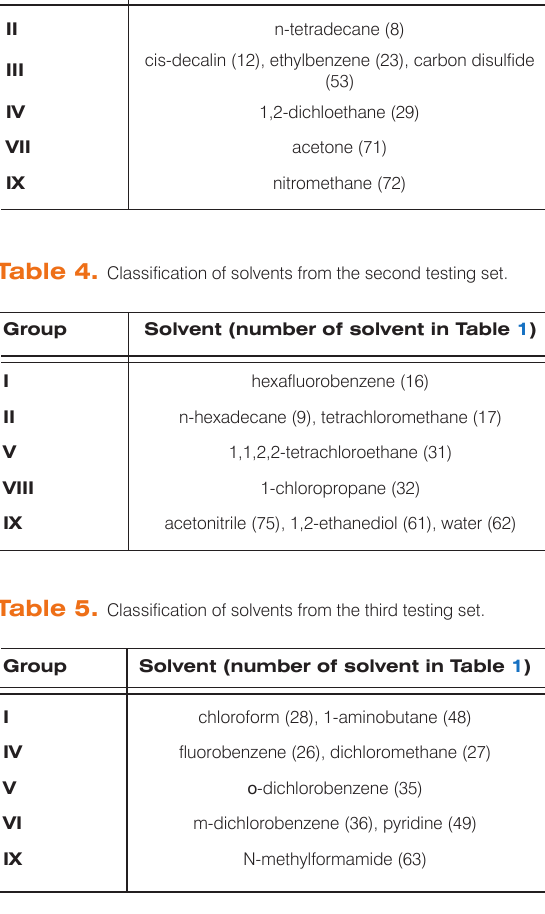
Table 3. Classification of solvents from the first testing set. Group